Question: What visual encoding does this figure use to show its data?
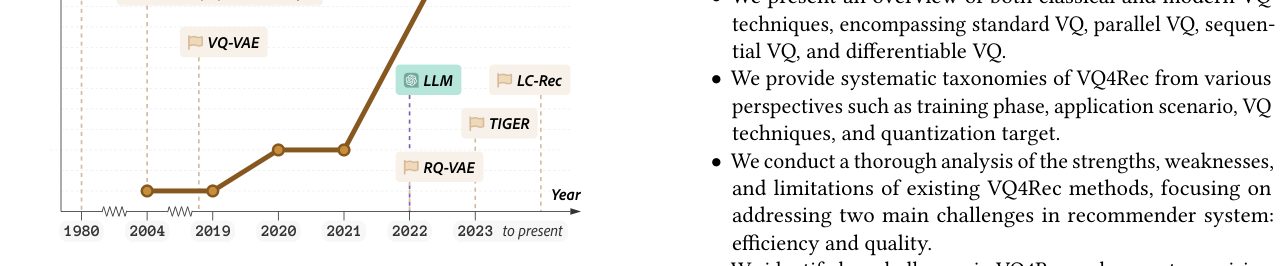
Answer: line